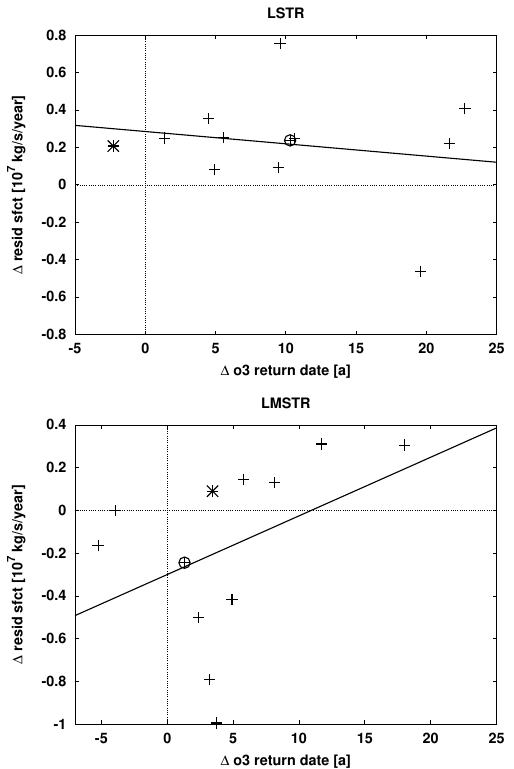
Fig. 7. Top: hemispheric differences (NH − SH) in the strength of trends in the residual circulation mass flux at 70hPa plotted against hemispheric differences (SH − NH mid-latitudes) in lower strato- spheric return dates for twelve different models (crosses) and their linear fit (line). Bottom: same as above but hemispheric differences in 100hPa residual circulation mass flux trends against lowermost stratospheric return date differences. The model marked with a cir- cle is NIWA-SOCOL; the model marked with a star is